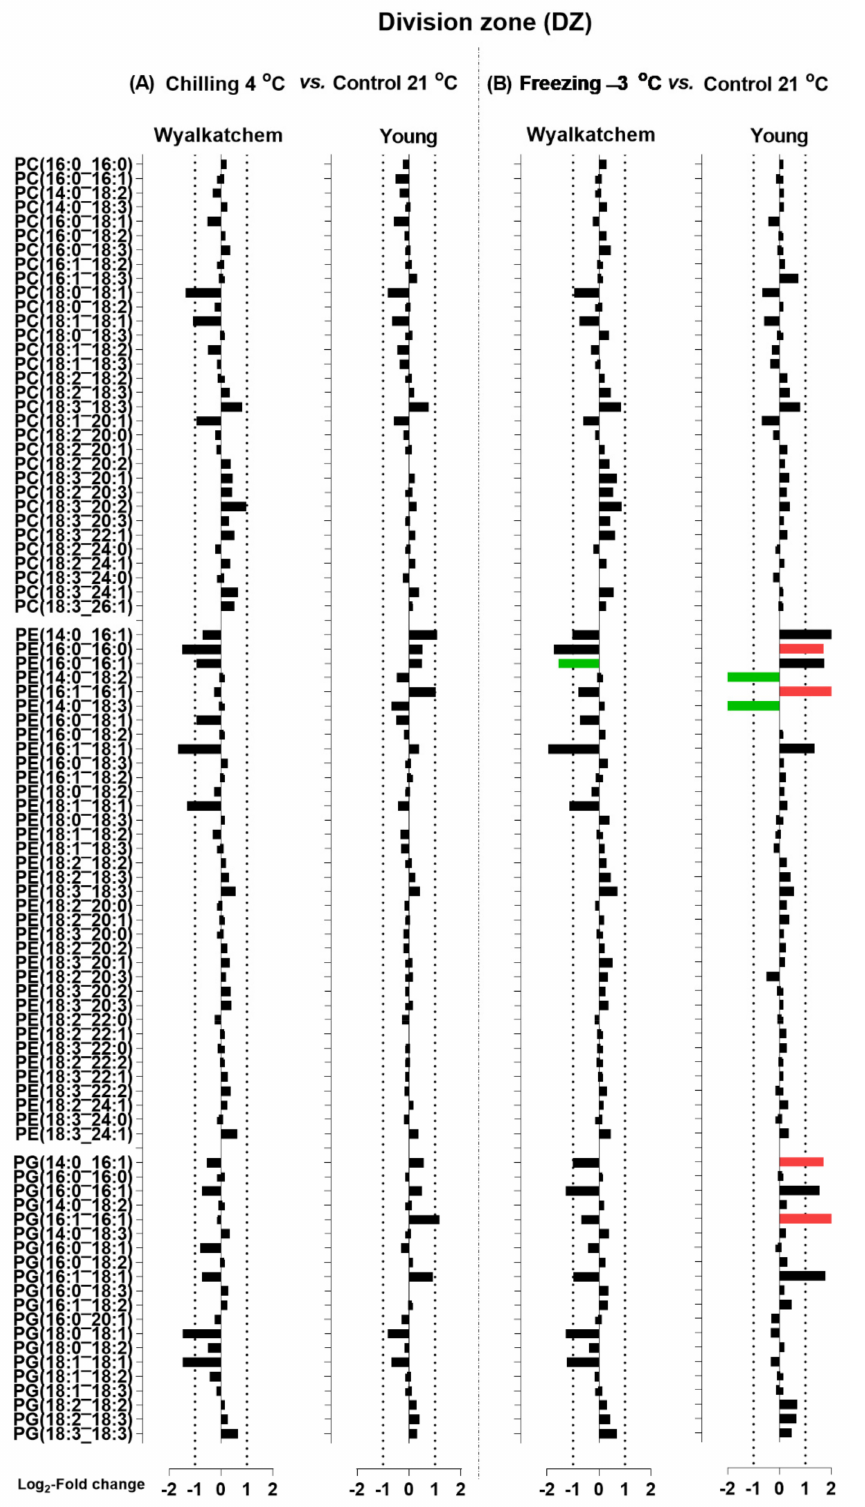
Figure 6. Log 2 -fold changes of PC, PE and PG species in the division zone (DZ) of the cold-sensitive Wyalkatchem and cold-tolerant Young after exposed to ( A ) chilling and ( B ) freezing stresses. Sta- tistical significance was determined using an FDR-adjusted p -value of 0.05 as the cut-off. Green bar = significant decrease; Red bar = significant increase. Black bar represents lipid species that has no significant change after cold stress as compared to control. n =